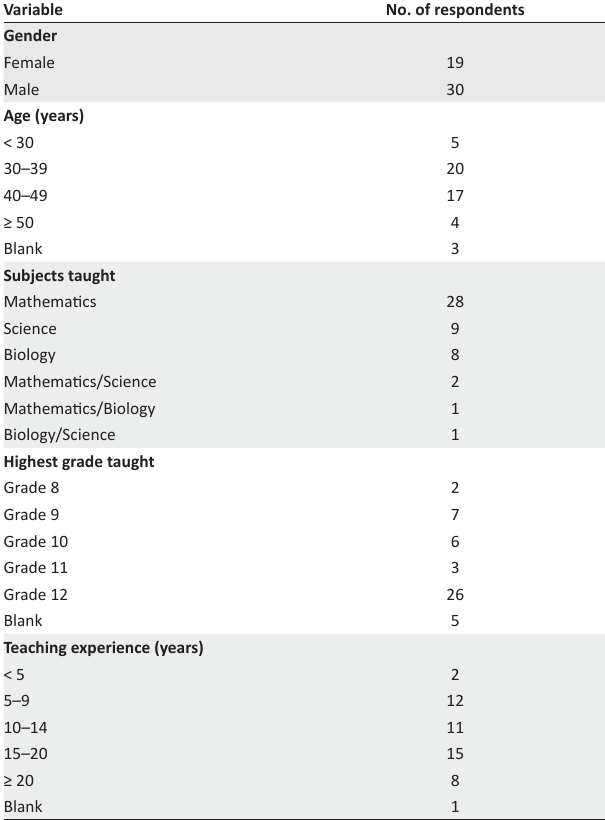
TABLE 1: Demographic